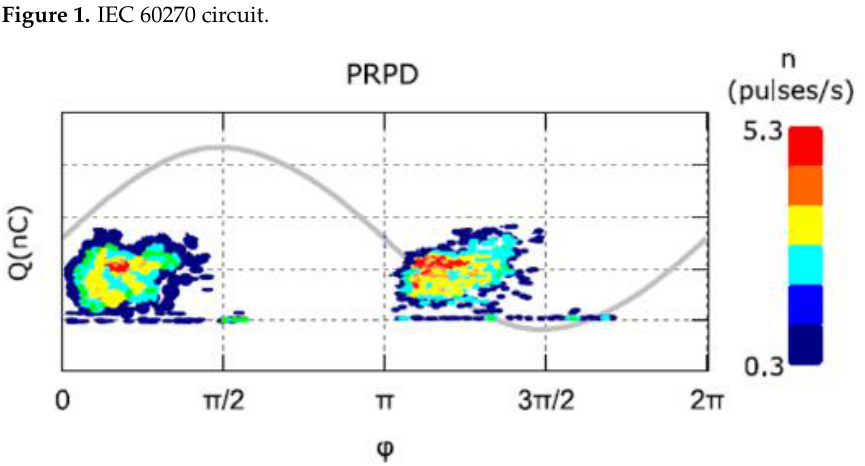
Figure 1. IEC 60270 circuit.